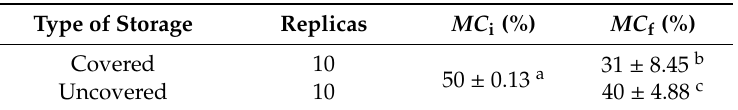
Table 1. Moisture content ( MC ) of Eucalyptus covered and uncovered woody biomass pile, expressed in percentage (%), where: MC i , initial moisture content and MC f , final moisture content, that is at the end the storage. MC values with different letters indicate mean values significantly different (p < 0.05) according to the several-sample ANOVA test.